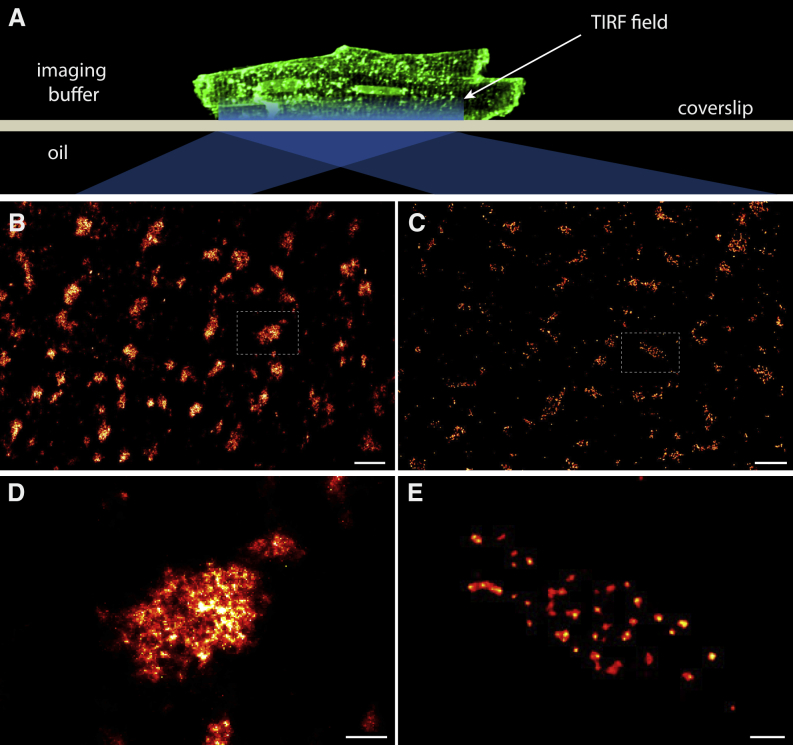
Visualization of RyRs in Peripheral Couplons of Ventricular Myocytes(A) TIRF illumination of peripheral RyR labels adjacent to the coverslip.(B and C) Both dSTORM (B) and DNA-PAINT (C) typically show RyR in clustered nanodomains (which are loosely in a transverse striated pattern) facing the surface plasmalemma (parallel to image plane).(D and E) Magnified views of clusters from these images (boxed regions in B and C) show the unresolved cluster sub-structure in dSTORM data (D), which contrasts with resolved punctate RyR patterns mapped with DNA-PAINT (E).Scale bars in (B) and (C), 1 μm, and in (D) and (E), 100 nm.